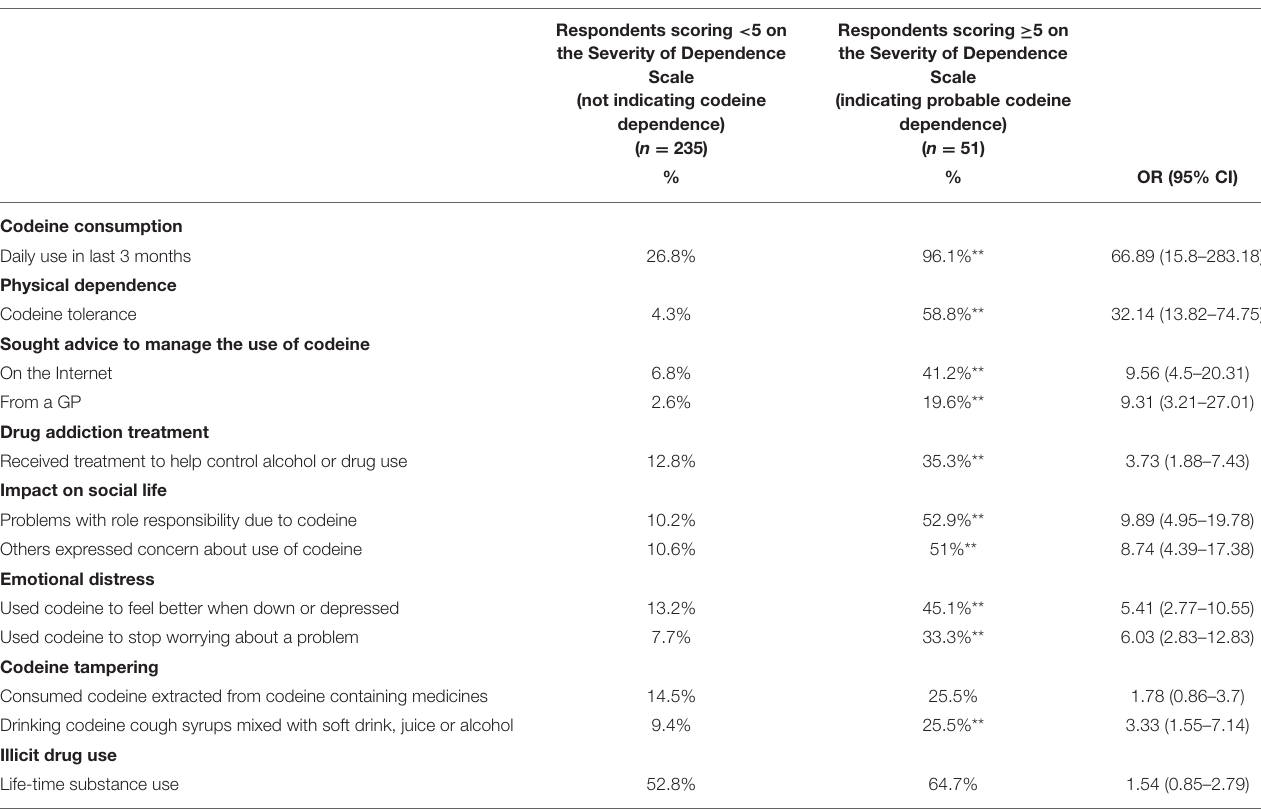
TABLE 3 | SDS score and its association with aberrant codeine related